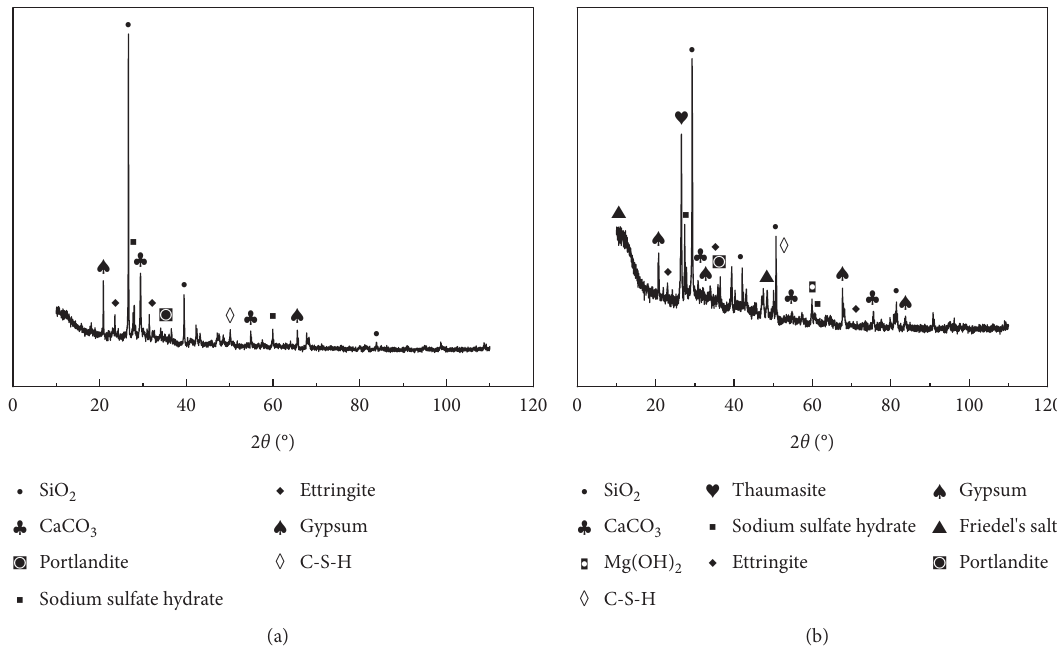
Figure 6: XRD of different positions of concrete. (a) The exposed end. (b) The embedded end.